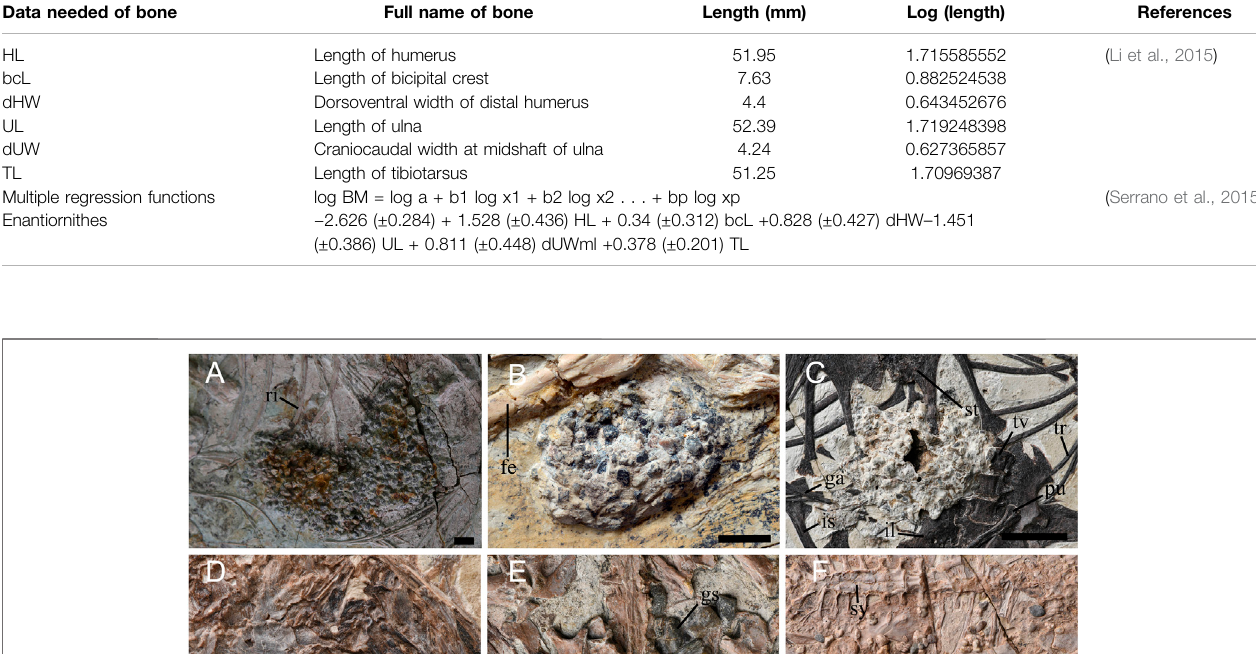
TABLE 1 | Data and formula to calculate the body mass of Bohaiornis guoi IVPP V17963. Data needed of bone